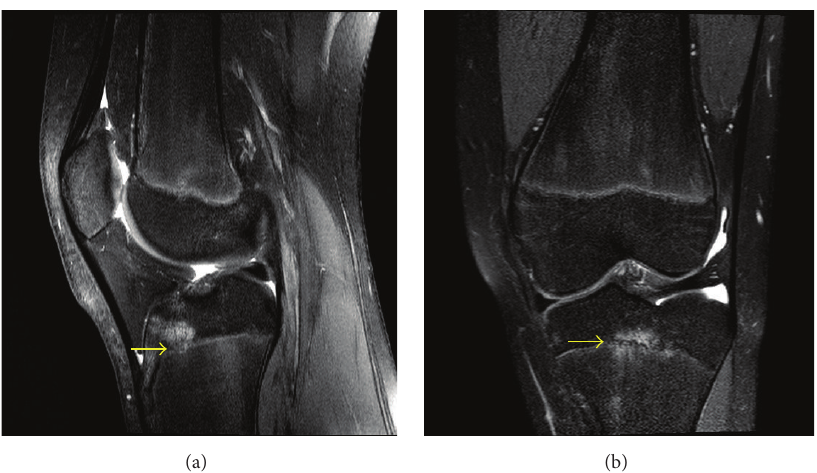
Figure 5: A 13-year-3-month-old female with FOPE zones at both proximal tibiae. Findings: (a) sagittal proton density fat-saturated image of the left knee shows 13mm in diameter area of periphyseal edema at the metaphyseal side of the proximal tibia physis (arrow). The proximal tibia physis is narrowed but remains open. (b) Coronal proton density fat-saturated image shows the periphyseal edema to be on both sides of the proximal tibia physis. The coronal image better demonstrates the periphyseal edema involvement of both the epiphyseal and metaphyseal sides of the physis (arrow). Technique: (a) sagittal PD fat-saturated MRI (TR = 2,959.1, TE = 30), ST = 3mm, spacing = 3.3 mm, FOV = 14 cm, and matrix = 364 × 261; (b) coronal PD fat-saturated MRI (TR = 2,504.2, TE = 30), ST = 2.5 mm, spacing = 3.3 mm, FOV = 15cm, and matrix = 312 ×